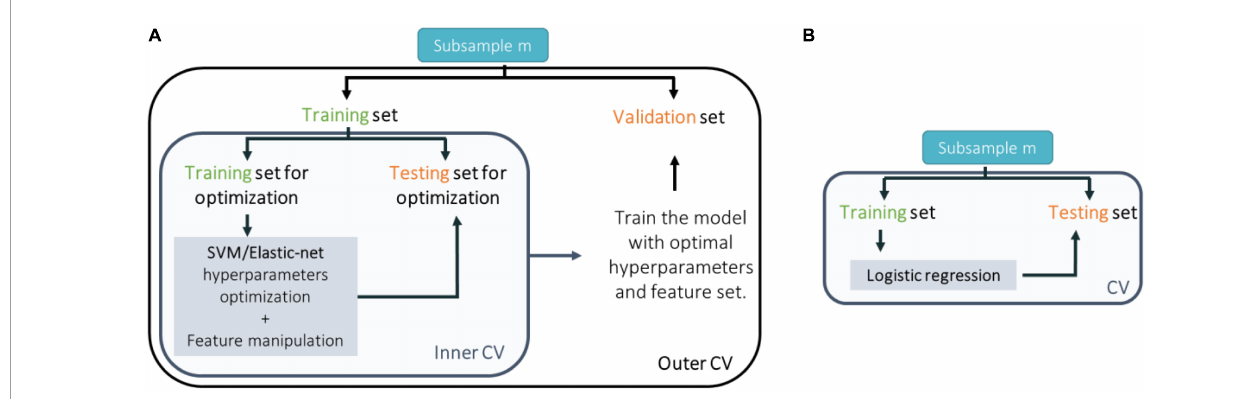
FIGURE2 Scheme of the cross-validation (CV) approach taken to train, test, and validate classification models trained with (A) neuroimaging data and support vector machines (SVM); genetic (single nucleotide polymorphisms or expression quantitative trait loci) or environmental (environmental risk factors) data and elastic-net; or (B) genetic (polygenic risk score) or environmental (environmental risk score) data and logistic